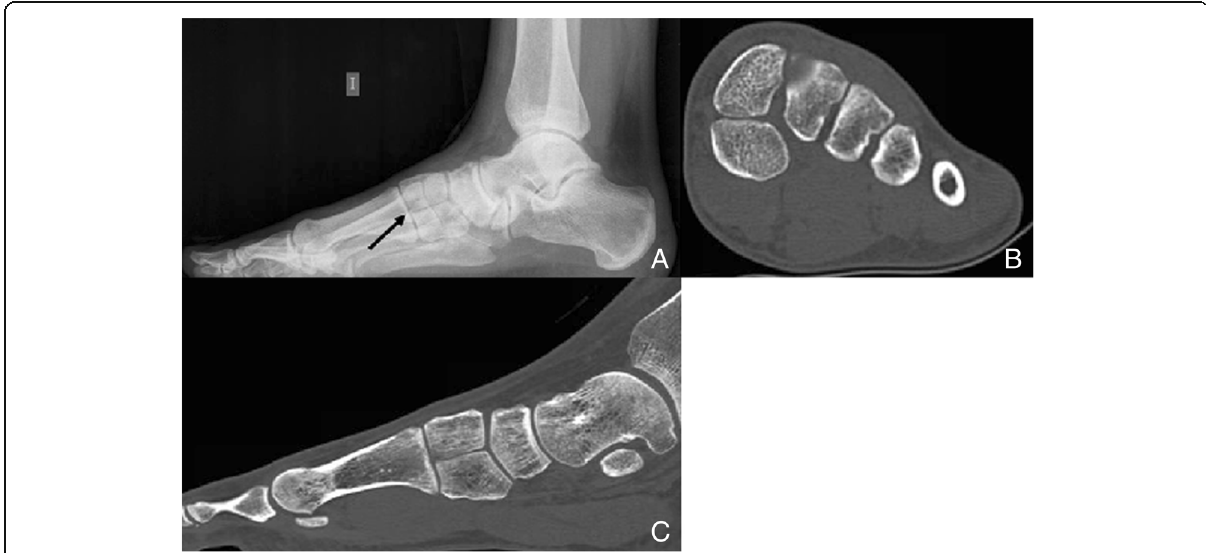
Fig. 9 Bipartite medial cuneiform. A 32-year-old man, on work up for left flat foot. Bilateral foot radiographs were taken. a Left lateral view demonstrates a bipartite cuneiform (finding was bilateral but only right foot shown). The black arrow marks the synchondrosis in between medial cuneiform components. b CT coronal reconstructions show a slightly larger plantar cuneiform. c Sagittal CT reconstruction shows that the addition of the volume of the two bones is larger than a normal medial cuneiform would